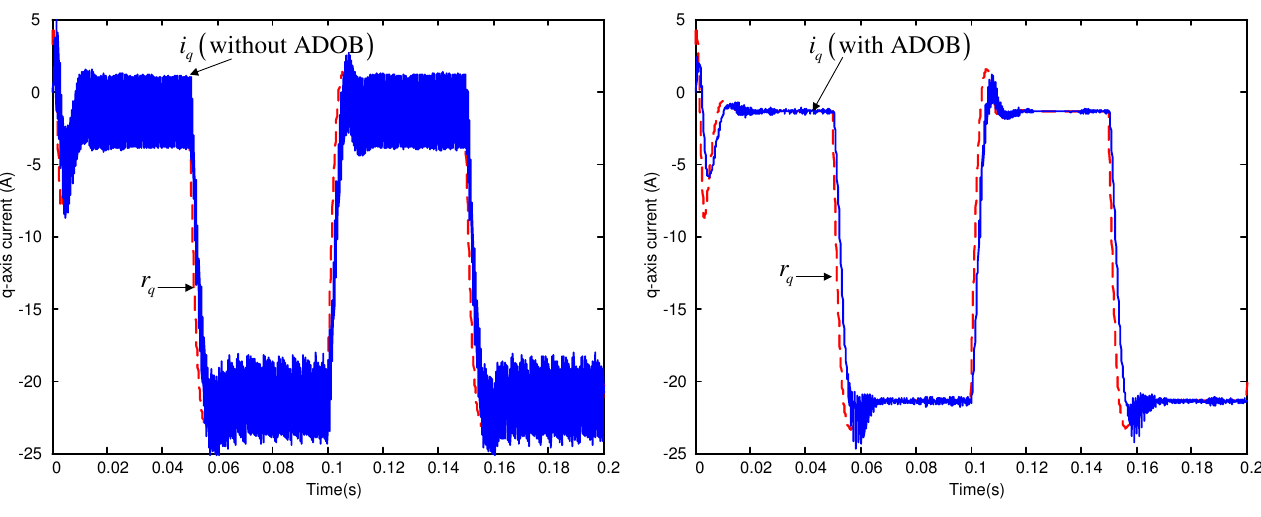
Figure 4. ( Left ) q -frame current response without ADOB; ( Right ) q -frame current response with ADOB.